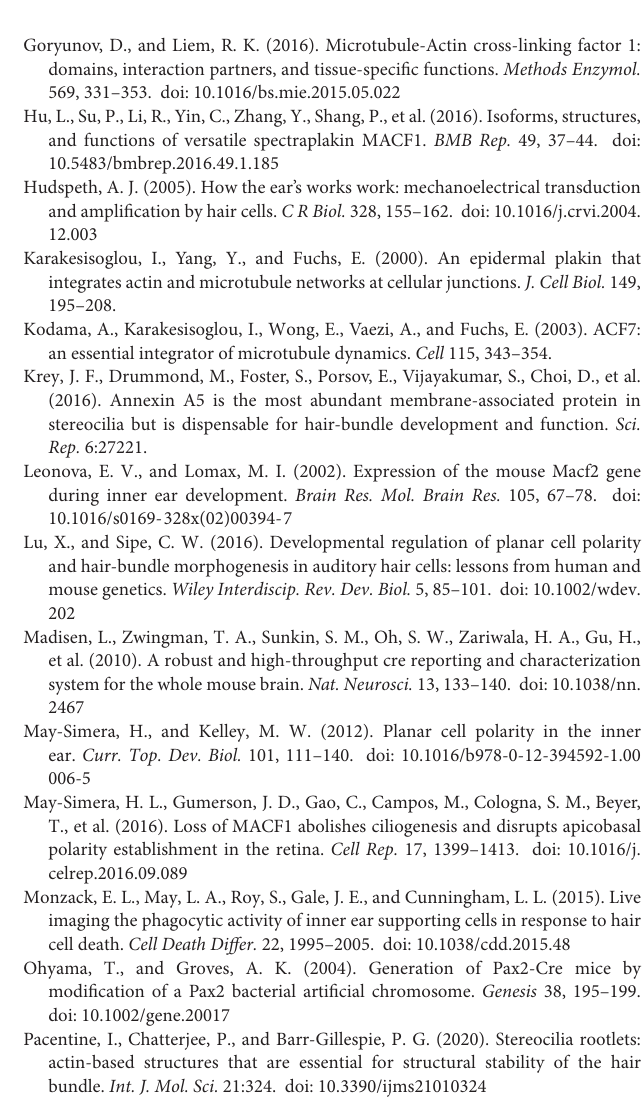
Supplementary Figure 1 | Representative whole-mount immunofluorescence on cochleae from experimental and control mice. (A,B) Macf 1 fl / − ; Pax2-Cre and control cochleae labeled with phalloidin (red) and a myosin7a antibody (green). For display, each whole cochlea divided in two is shown minus the hook region. (C) Schematics of cochlear regional boundaries. Incisions were made to sever the apical and basal regions from the middle turn. The cochleae were divided isometrically. Scale bar 50 µ